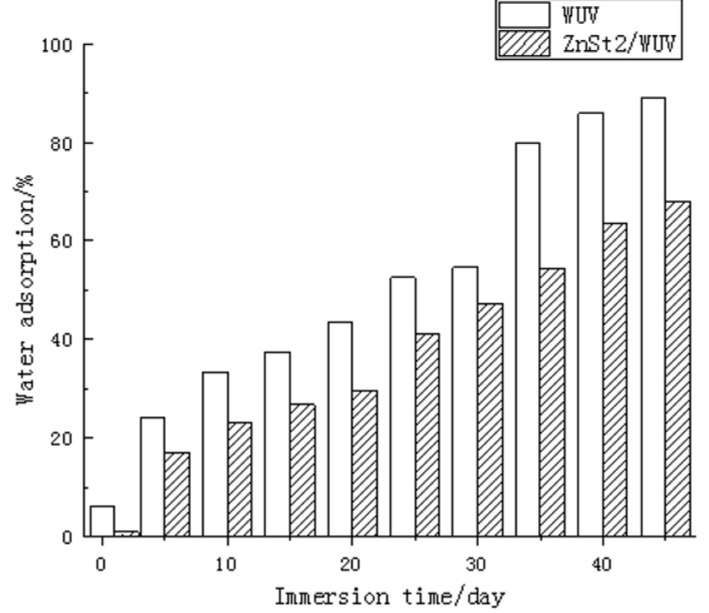
Figure 5. Water resistance test of WUV and ZnSt2/WUV.